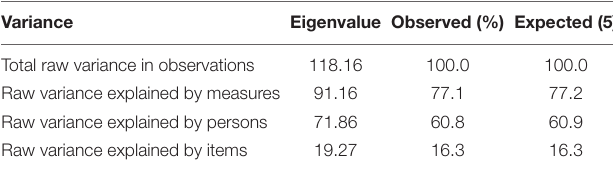
TABLE 6 | Standardized residual variance all 27